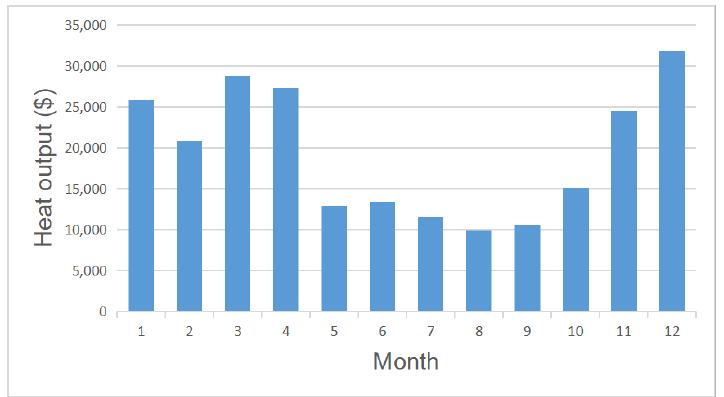
Figure 4. Monthly hot water demand with building.